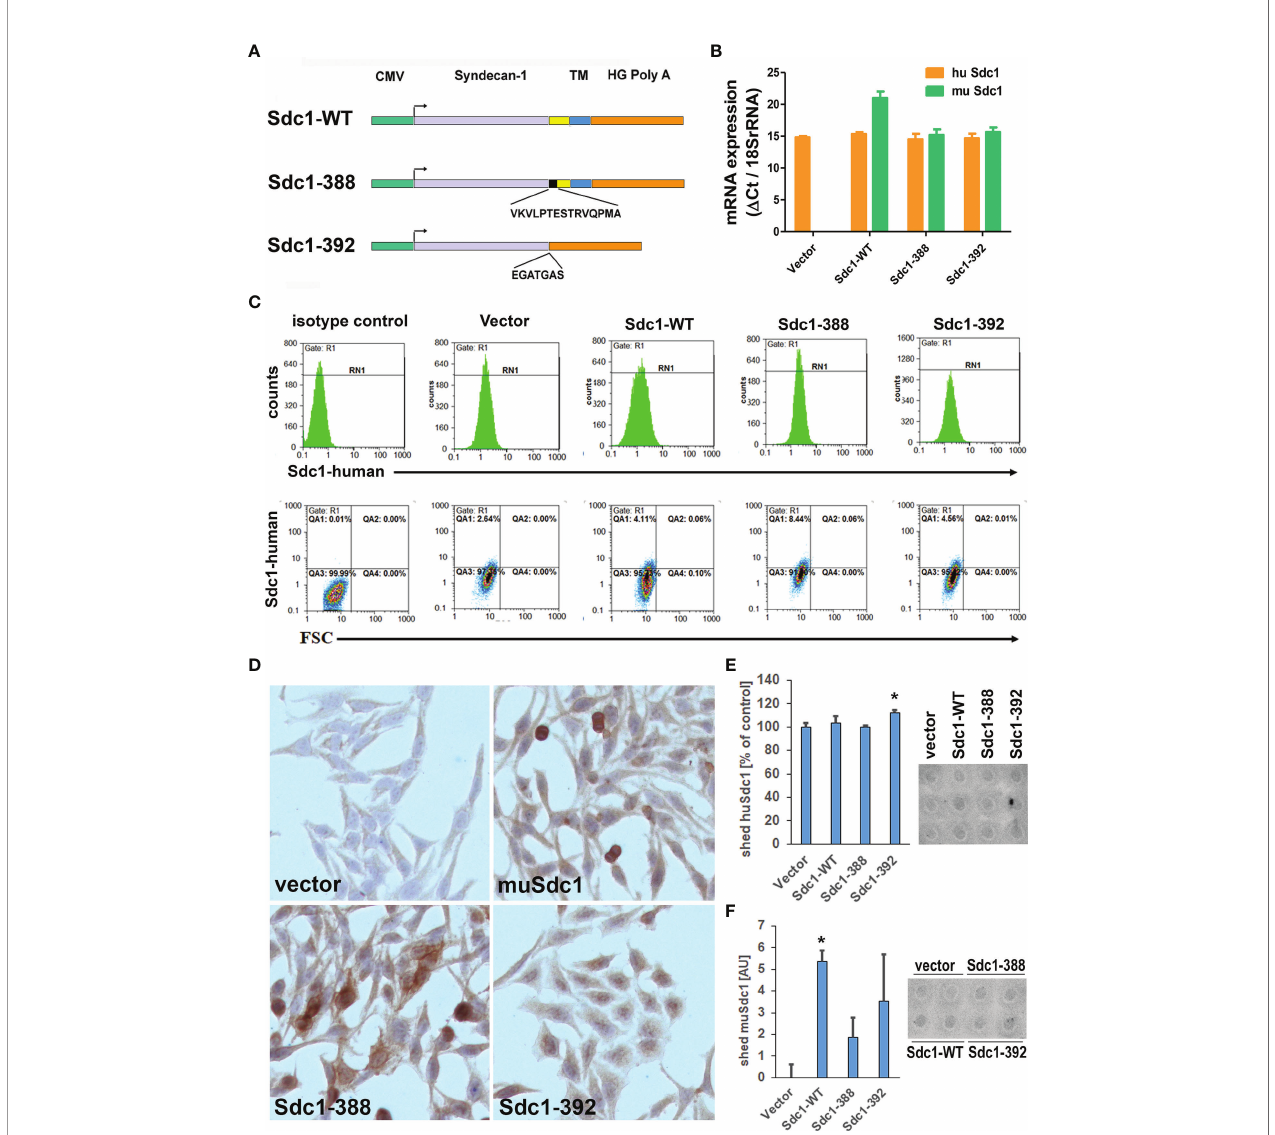
FIGURE 2 | Characterisation of HeLa cells overexpressing wild-type, constitutively membrane bound (Sdc-388) and constitutively shed (Sdc1-392) Sdc-1. (A) Schematic representation of the plasmid Sdc-1 cDNA inserts, CMV, cytomegalovirus promoter; yellow box, juxta-membrane domain; Black box, non-cleavable CD4 sequence; blue box, transmembrane and cytoplasmic domain, orange box, poly-A-tail; Sdc1-WT murine wild-type form; Sdc1-388, uncleavable construct 388;Sdc1- 392, constitutively shed construct 392. (B) Quantitative PCR analysis of murine (mu Sdc-1 and human (Hu Sdc-1) Sdc1 expression. Sdc-1 expression was related to the housekeeping gene 18SrRNA. n ≥ 3, error bars = SEM. (C) Detection of human Sdc-1 protein expression at the surface of the transfected HeLa cell lines using fl ow cytometry. Cells were stained for isotype control mouse IgG1-PE and mouse anti-human Sdc-1 (CD138)-PE and the cells were subjected to fl ow cytometry. Human Sdc-1 is expressed at the cell surface of all cell types. (D) Immunocytochemistry for murine Sdc-1, demonstrating expression of murine Sdc-1 in Sdc1-WT, Sdc-1-388 and Sdc-1 392 transfected cells (brown-red staining). Original magni fi cation 10x. (E, F) Detection of shed human (E) and murine (F) Sdc-1 in cell culture supernatants of the transfected cell lines. Conditioned media were collected from the cell lines indicated and 600 µl were subjected to a dotblot assay and quanti fi ed by Image J densitometric analysis. Left panels = quanti fi cation, right panels= representative dot-blots, n>3, *= p<0.05 Sdc1-392 compared to vector control (t-test). The cell lines shed comparable amounts of human Sdc-1 into the culture media, with a moderately, yet signi fi cantly enhanced amount in Sdc1-392 cells. Shed amounts of murine Sdc-1 were variable, with Sdc1-WT cells showing signi fi cantly increased levels of shed murine Sdc-1 compared to vector control (n>3, *p<0.05,